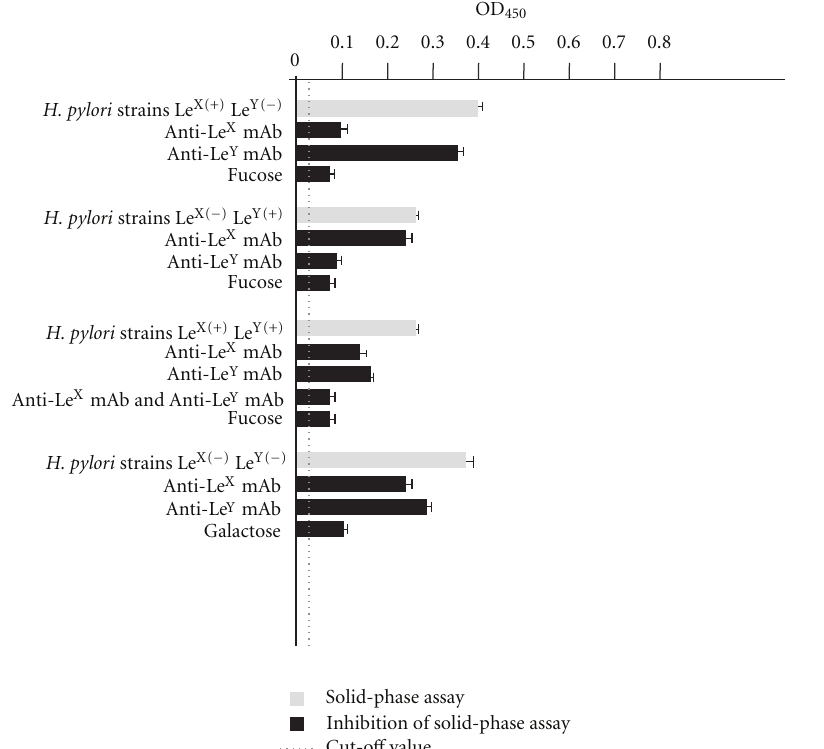
Figure 1: The binding of H. pylori whole cells positive or negative for Le X , Le Y , or Le XY determinants with a soluble DC-SIGN receptor. The binding estimated by the solid-phase assay (grey bars). The specificity of binding estimated by the solid-phase inhibition assay (black